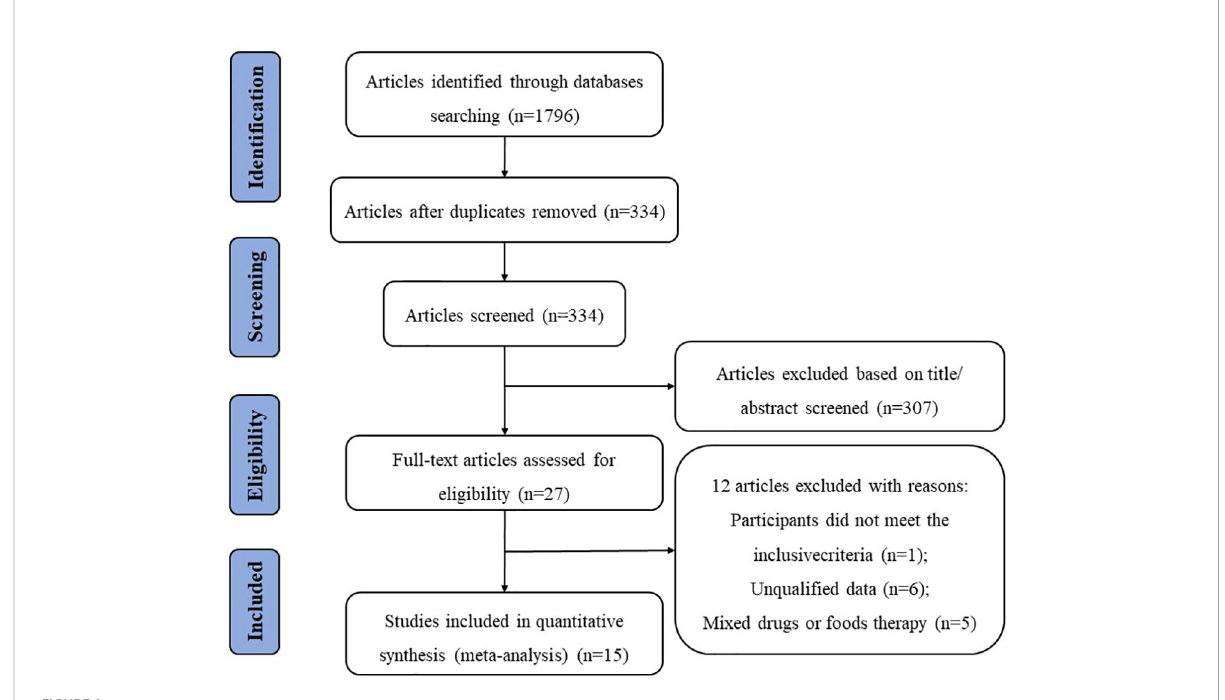
FIGURE 1 Flow chart of the literature selection